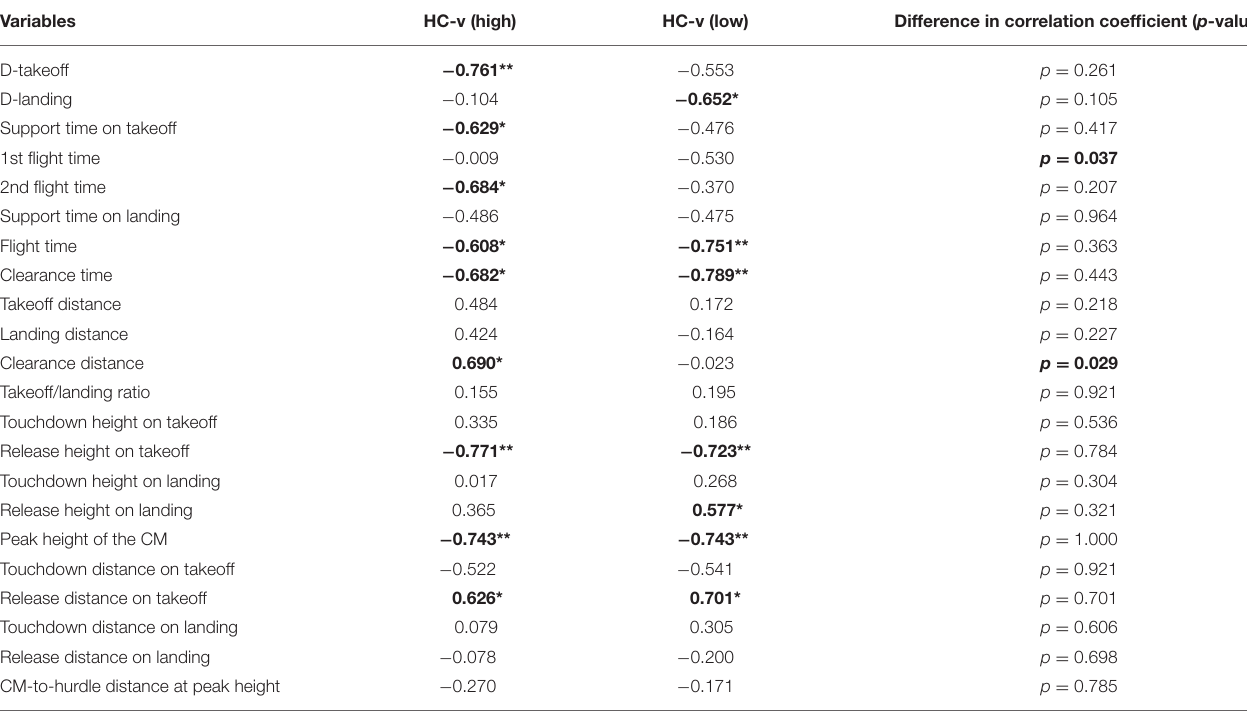
TABLE 2 | Relationship between hurdle clearance velocity (HC-v) and each variable in the high and low conditions and differences in correlation coefficients.